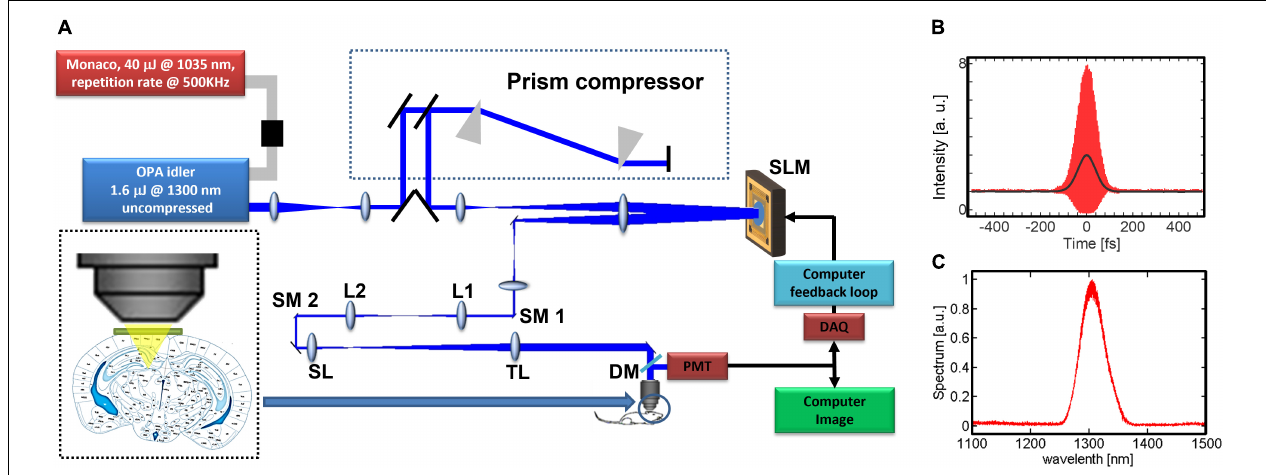
FIGURE 1 | System description: (A) experimental setup. The prism compressor compensates the dispersion to minimize the pulse width at the focus of the objective lens. The microelectromechanical (MEMS)-based SLM has 1024 elements and is imaged onto two galvo scanning mirrors (SM1, SM2) and the back aperture of the objective. We use the non-linear signal from the image in order to close the feedback loop, L1, L2, lenses for beam relay; SL, scan lens; TL, tube lens; DM, dichroic mirror. (B) Measured interferometric second-order autocorrelation trace of the pulse at the objective focus, with dispersion pre-compensation. The pulse’s full width at half maximum (FWHM) is ∼ 70 fs assuming a sech 2 ( τ ) temporal pulse intensity profile. (C) Measured OPA output spectrum.